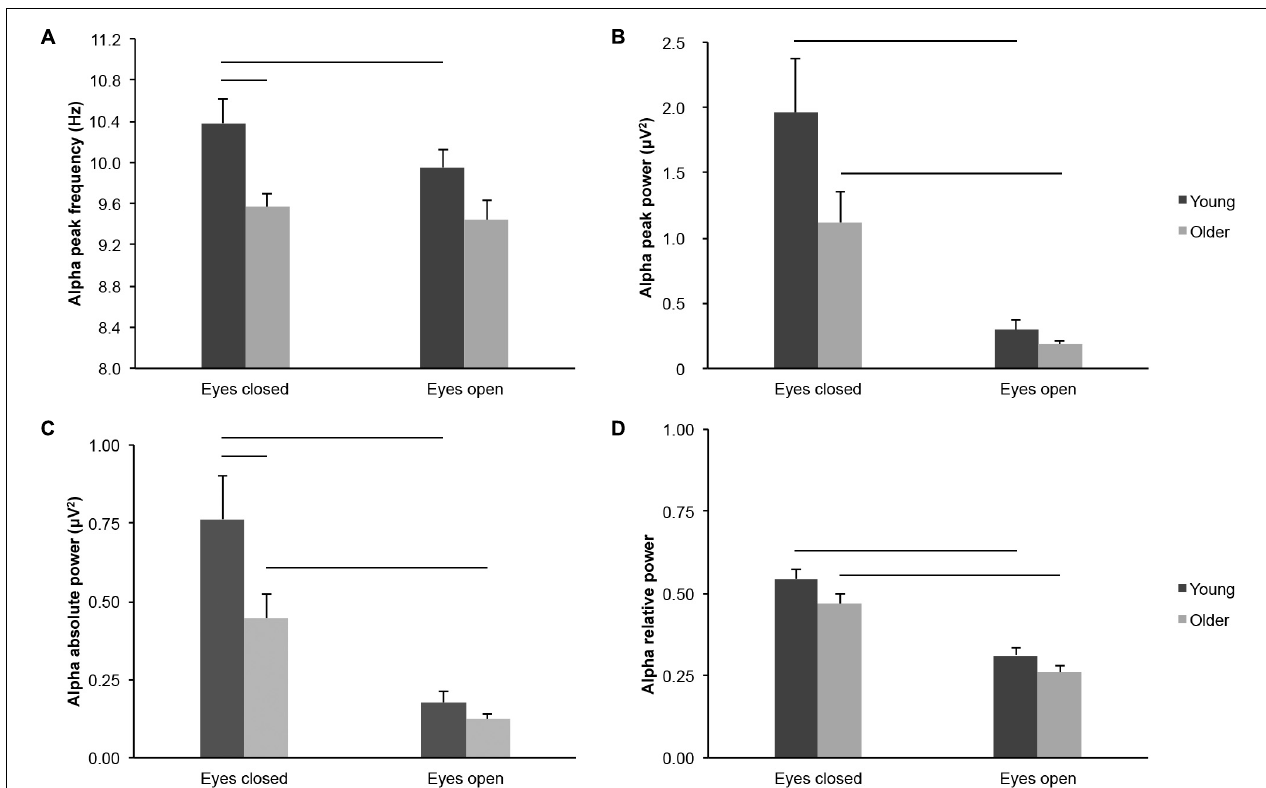
FIGURE 3 | Alpha-band activity measured across the scalp in healthy 20–30-year-old (Young; dark gray bars) and 65–75-year-old (Older; light gray bars) adults. (A) Alpha peak frequency. (B) Alpha peak power. (C) Alpha absolute power. (D) Alpha relative power. Average ± SEM. Horizontal bars indicate statistically significant differences between age groups or eye conditions ( p <